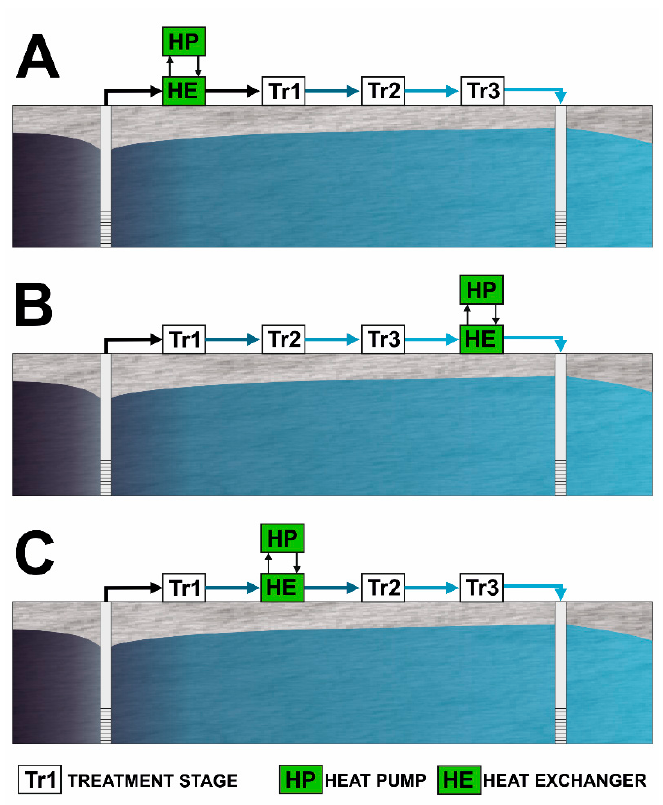
Figure 2. Possible positions for heat exchange: ( A ) upstream of all treatment stages; ( B ) downstream of all treatment stages; ( C ) between two treatment stages.